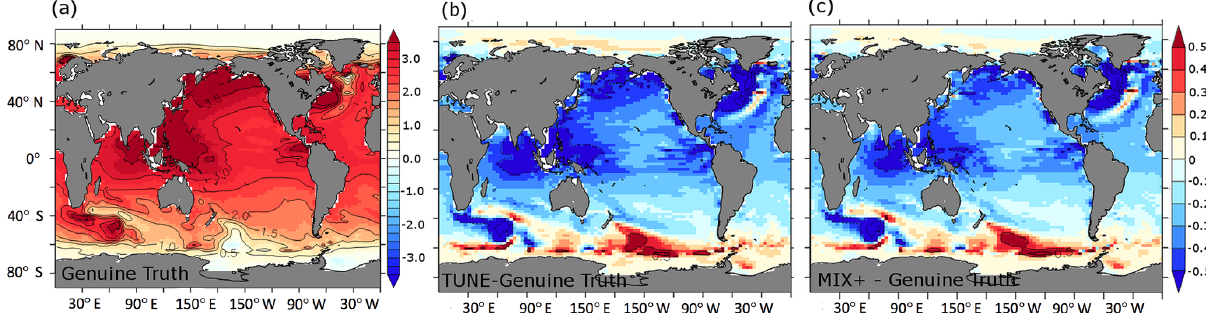
Figure 8. Comparison of sea surface temperature warming in response to RCP8.5 emissions. (a) The contours (both colored and labeled) denote the differences in simulated sea surface temperature anomalies between the years 2100 and 1850 in the projection based on the Genuine Truth setup in units of Kelvin. Panels (b) and (c) show the same differences for the projections based on TUNE and MIX+ relative to the Genuine Truth, respectively. Negative numbers indicate regions where the Genuine Truth warmed more than TUNE in the year